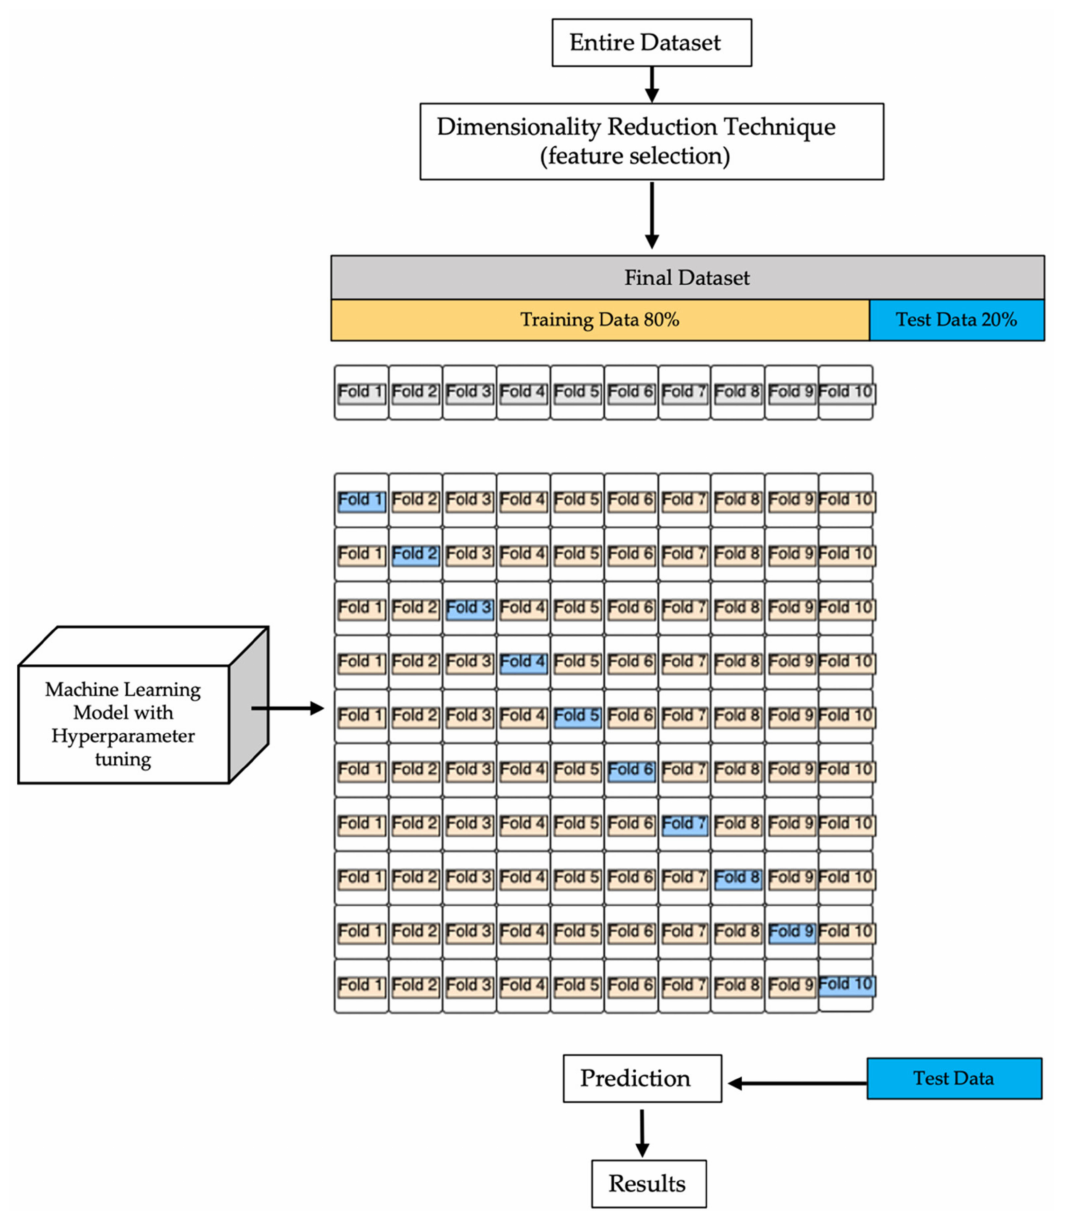
Figure 2. Machine learning block diagram model. After we reduced the dimensionality of the entire initial dataset, we split the final set into two subgroups: training set (80% of data) and test set (20% of data). On training data, we performed k-fold cross-validation (k = 10), as shown in the diagram. To make a prediction on training data, after grid search hyperparameter tuning, we evaluated the real output (test data), and we analyzed the results by classification performance for each classifier. In the majority of cases, discrete splitting functions are univariate. A split in an internal node based on the value of a single attribute is referred to as “univariate”. As a result, the in- ducer seeks out the best attribute on which to split the data. There are numerous univariate criteria from which to choose. According to the origin of the measure: information theory, dependence, and distance. According to the structure of the measure: impurity-based criteria, normalized impurity-based criteria, and binary criteria. We used grid search to optimize two hyperparameters: the impurity-based criterion and the maximum depth of the tree. The best accuracy was obtained by building our decision tree with a maximum depth of five and the entropy impurity